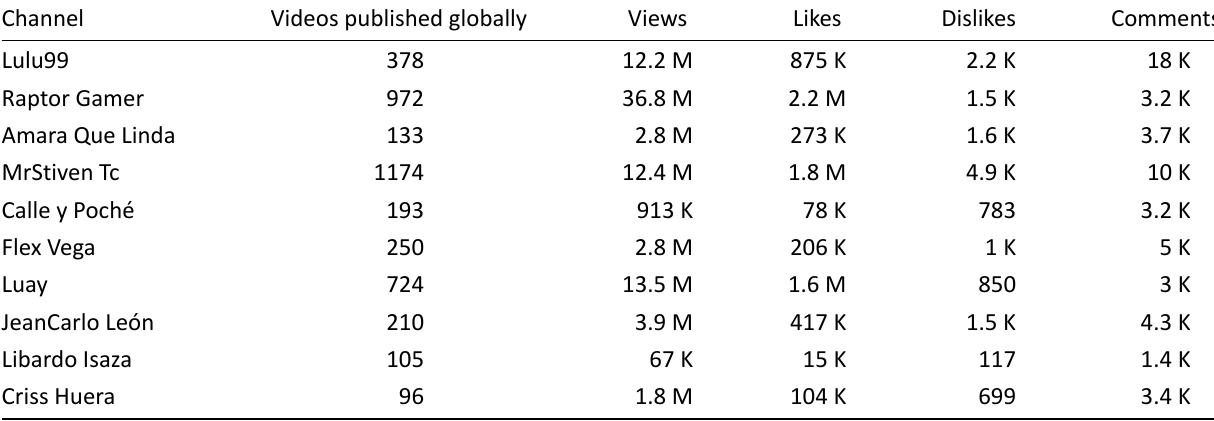
Table 4. Impact of YouTubers’ channels in the Andean Community. Channel